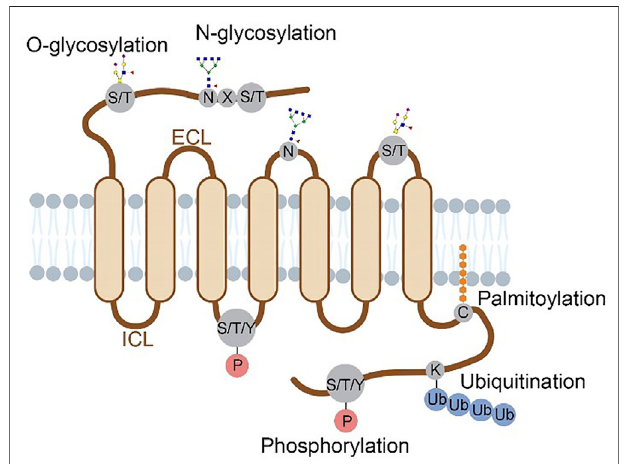
FIGURE 1 | Structural localization of GPCR post-translational modi fi cations overviewed in this review. Four major types of PTMs are distributed on theN-terminus, ECLs, ICLsand C-terminus ofaGPCR protein. Glycosylation occurs on the N-terminal and ECL domains, with N-glycosylationatNofthesequencemotifN-X-S/T(X ≠ P)and O-glycosylation at S/T residues. Phosphorylation occurs at S, T or Y residues on the C-terminal and ICL domains. Ubiquitination occurs at K residues and palmitoylation at C residues, both on the